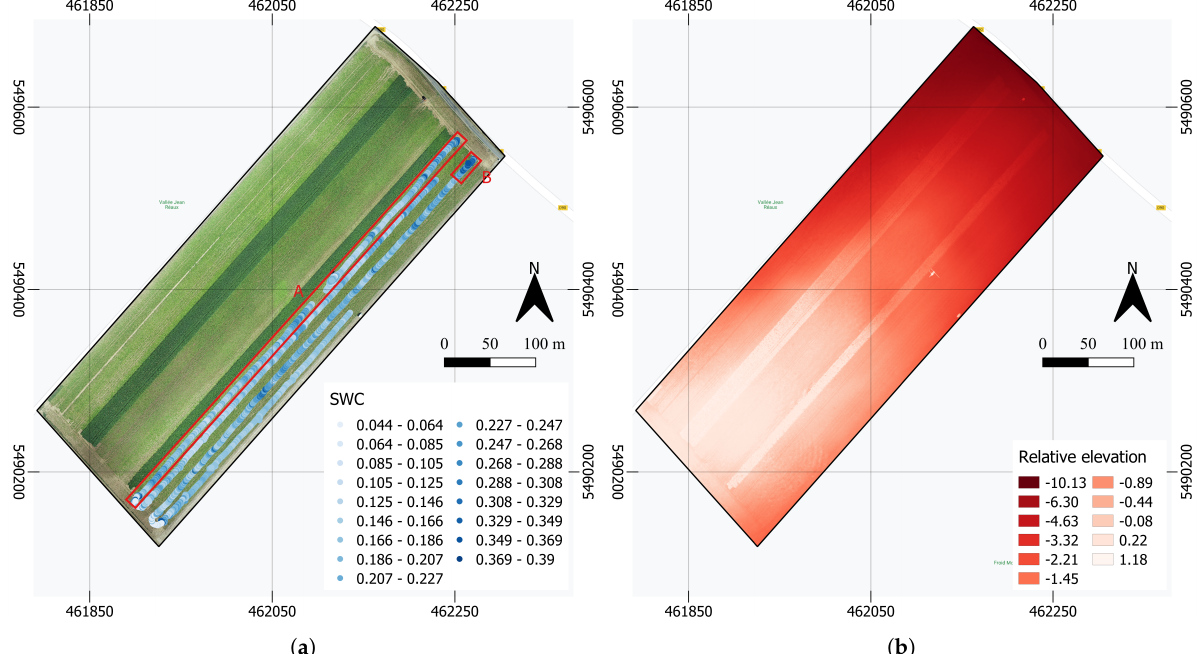
Figure 9. Potato field in Ferrières, Vallèe Jean Rèaux, Sains-Morainvillers, France. ( a ) volumetric soil moisture measurement points and orthophoto. Area A indicates the long profile of TDR mea- surements, and B indicates the short profile; ( b ) digital surface model map. Coordinates are in WGS84/UTM zone 31 N